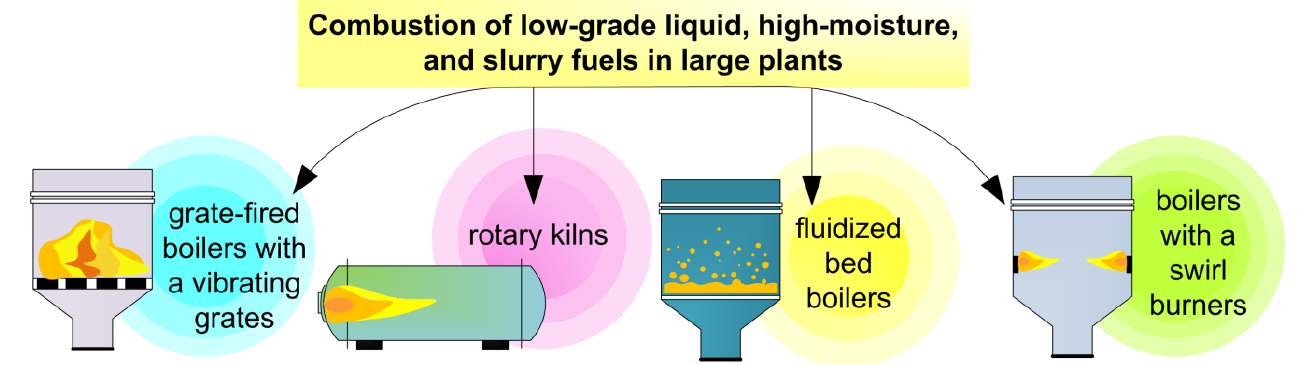
Figure 2. The main types of large plants used for the combustion of low-grade, high-moisture, and slurry fuels.